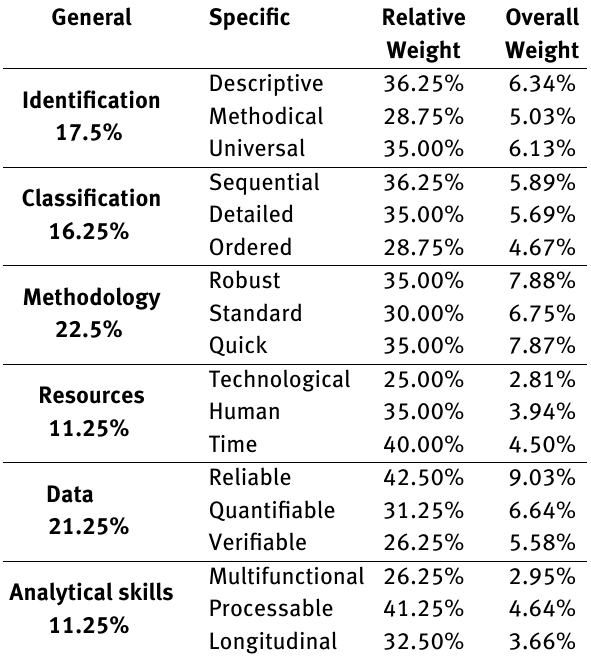
Table 1: Weighted criteria and indicators for the inspection method-